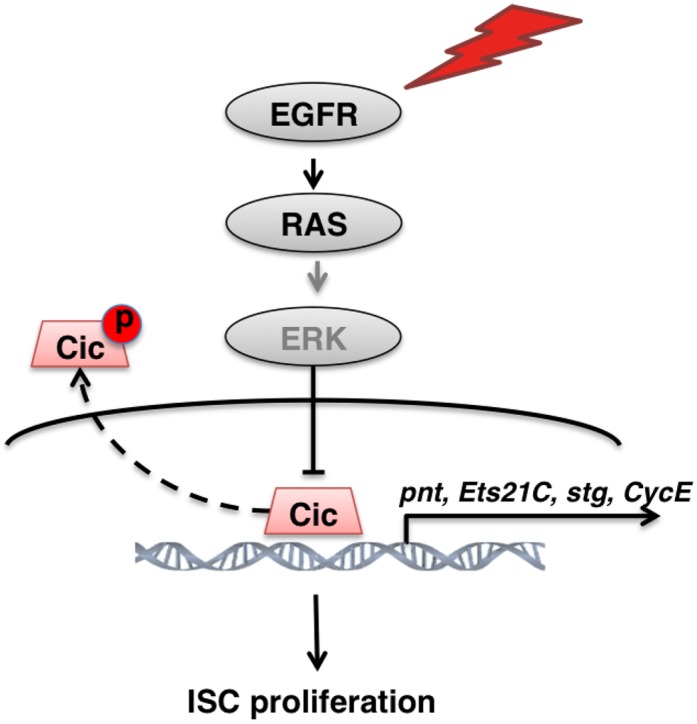
Model for Cic control of Drosophila ISC proliferation.Upon damage, activated EGFR signaling mediates activation of ERK, which phosphorylates Cic, and relocates it to the cytoplasm. As a result, stg, CycE, Ets21C and pnt transcription are relieved from Cic repression, and induce ISC proliferation.